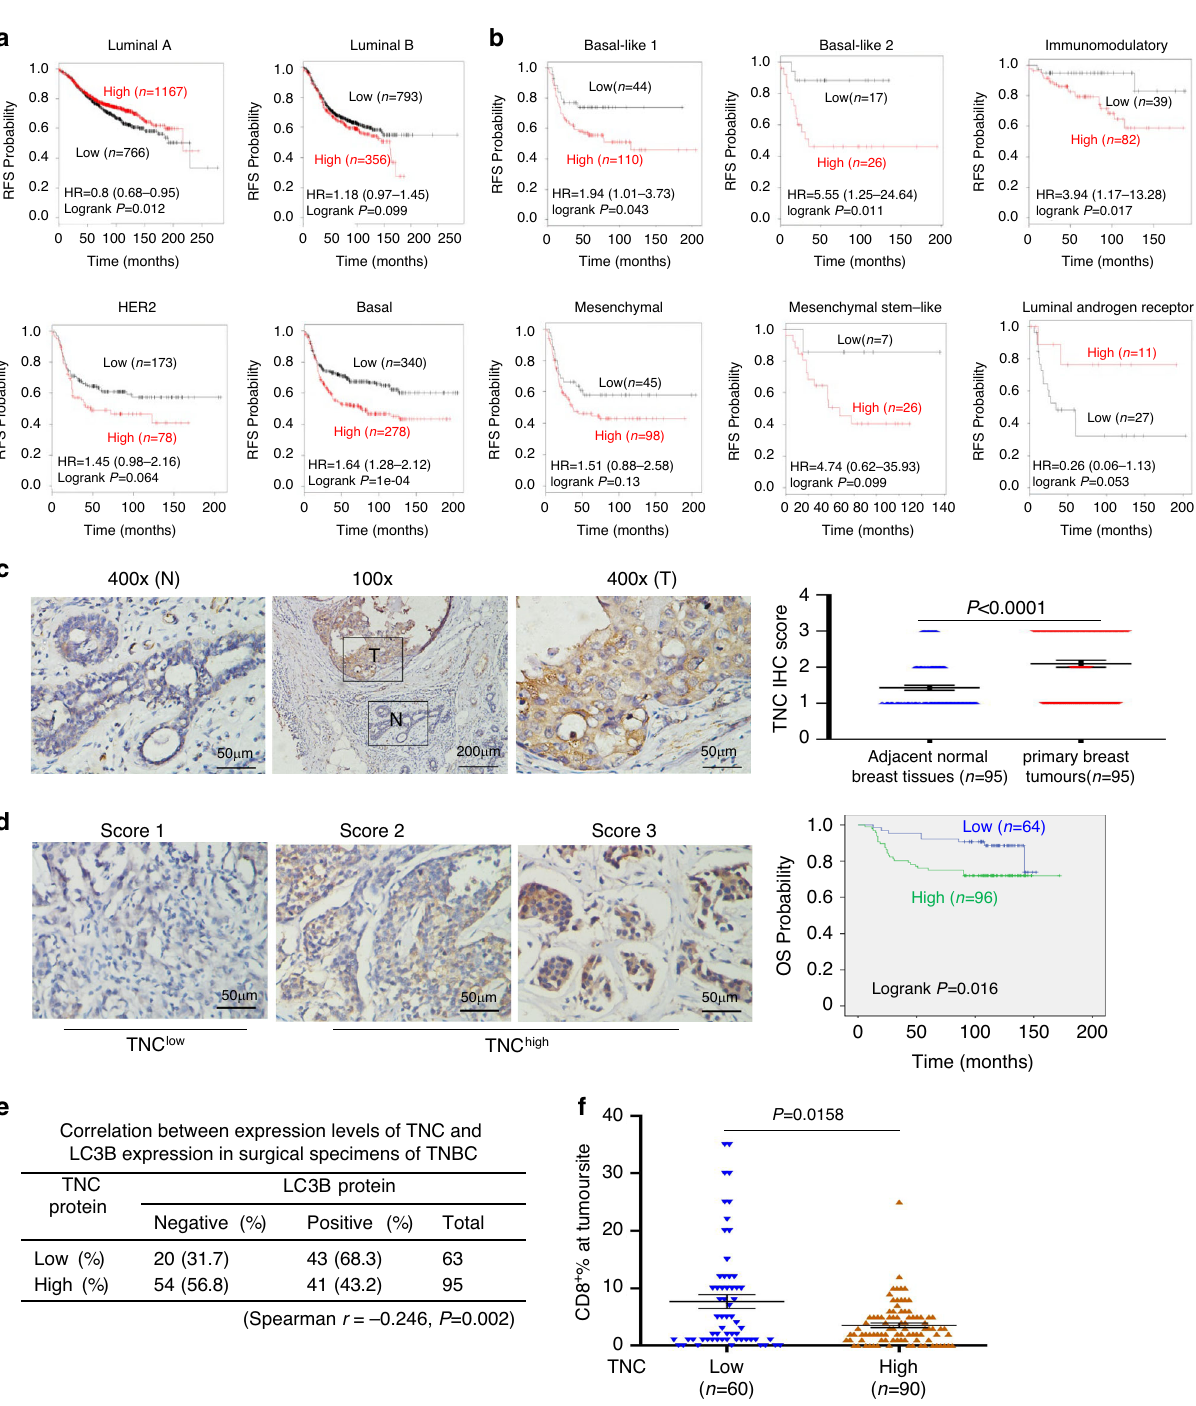
Fig. 7 TNC is correlated with LC3B and CD8 + T cells in clinical TNBC samples. a , b Kaplan – Meier analysis of RFS based on TNC (201645_at) mRNA levels using the KM-plotter breast cancer database (http://kmplot.com/analysis). Auto select best cutoff was chosen in the analysis. All patients were strati fi ed according intrinsic subtype as indicated ( a ). Basal patients were strati fi ed according the known six Pietenpol subtypes ( b ). c The representative images of strong TNC staining in tumour cells (T) and weak staining in the matched adjacent normal cells (N) (Left). Quantitative IHC analysis of TNC staining of primary breast tumours and adjacent normal breast tissues was shown ( n = 95). d The representative images for each IHC score of TNC staining in 160 primary TNBC tumours were shown. Score 1 represnted low TNC expression, Scores 2 and 3 represnted high TNC expression (left). Kaplan – Meier analysis of OS for patients. All patients were strati fi ed by expression of TNC (right). e The correlation of LC3B with TNC expression status in 158 primary TNBC tumours. Spearman's correlation coef fi cient r and P values were given at the bottom. f The correlation of CD8 + T-cell in fi ltration with TNC expression status in 150 primary TNBC tumours. Error bars represent mean ± SEM. The P value in c , f was determined by Wilcoxon matched-pairs signed rank test (two-sided). Survival curves in a , b , d were plotted by the Kaplan – Meier method and assessed using the log-rank test, and univariate Cox proportional hazards regression was carried out to identify HR and 95%